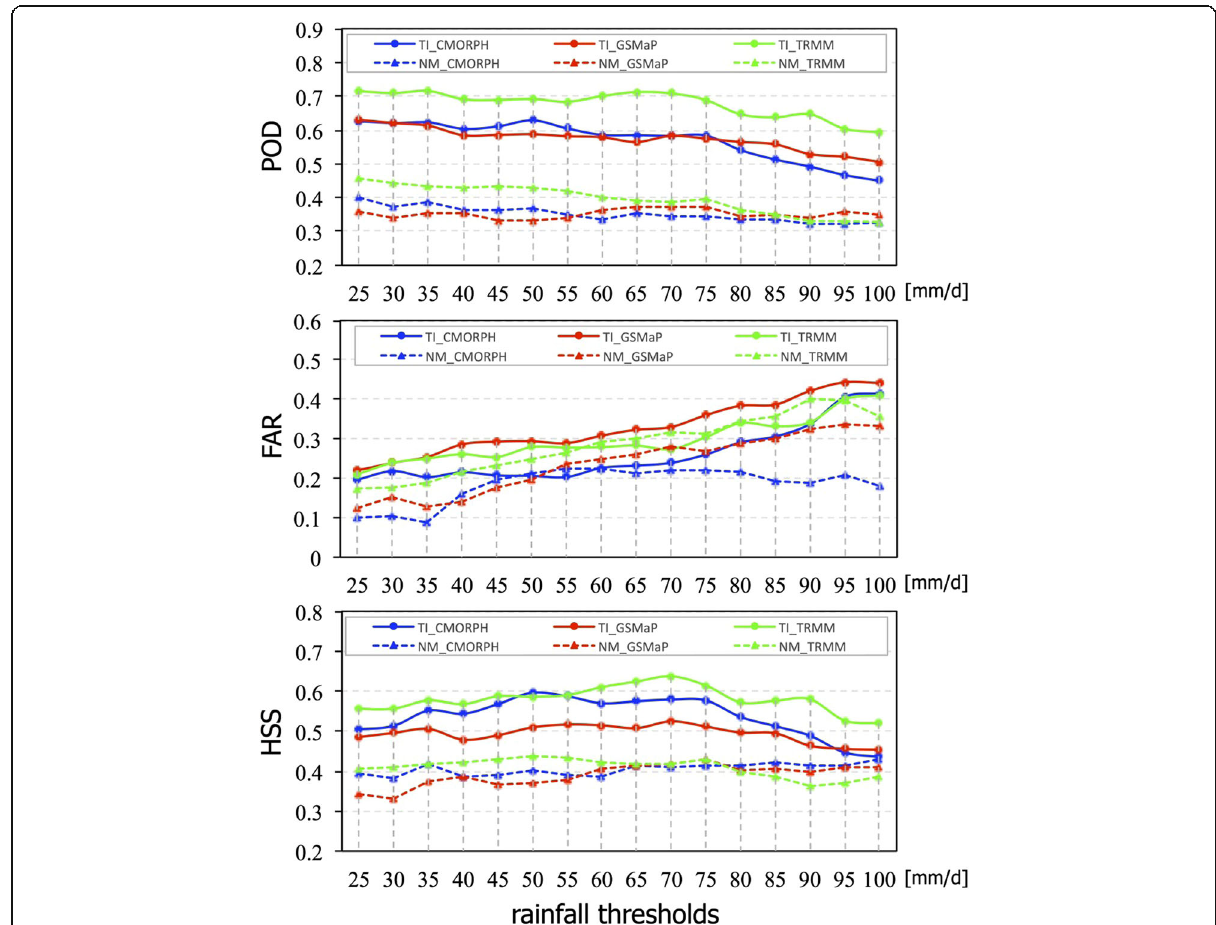
Fig. 11 The relations between rainfall thresholds and the POD, FAR, and HSS values of SPDs ’ daily rainfall estimates with rain gauge observations at the seven stations on the WHR TI and NM days listed in Table